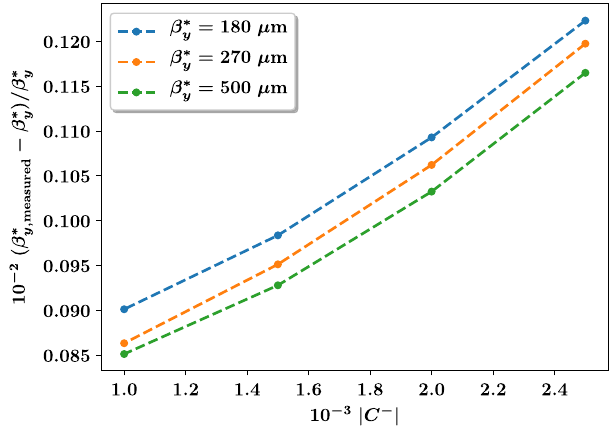
FIG. 7. Deviations in the calculated β (cid:1) y for different values of coupling strength in LER. The simulations are done for β (cid:1) y values of 500 μ m, 270 μ m and 180 μ m. The quadrupole modulations are done such that the tune shifts away from the difference coupling resonance. The tune separation is 0.04.